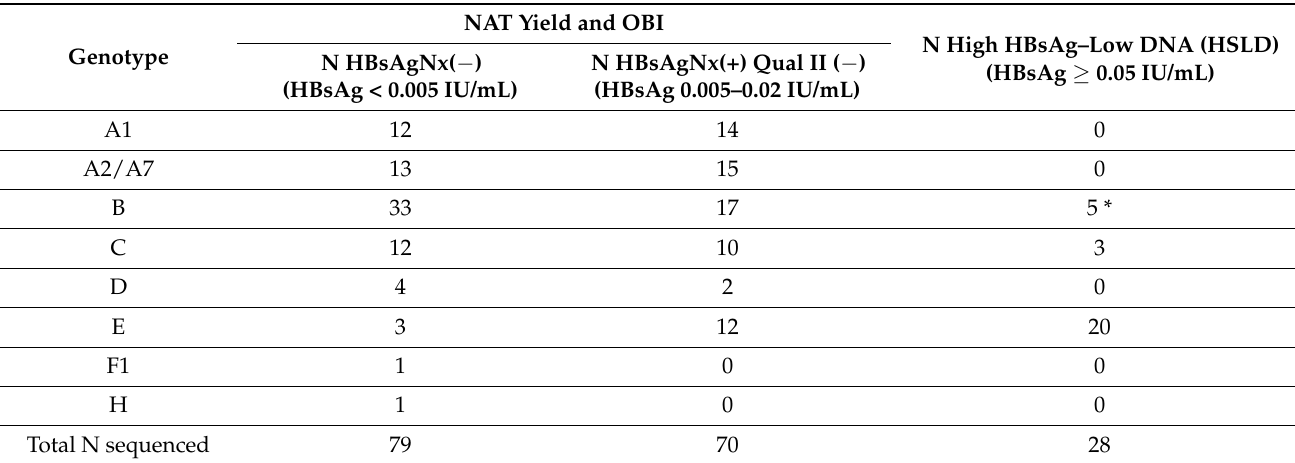
Table 4. Genotype results for sequenced samples.